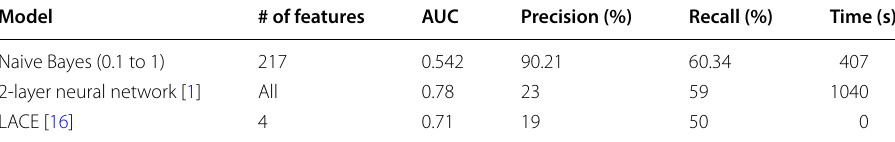
Table 3 Comparison of the performance of our models, model by Jamei et al. [1] and LACE